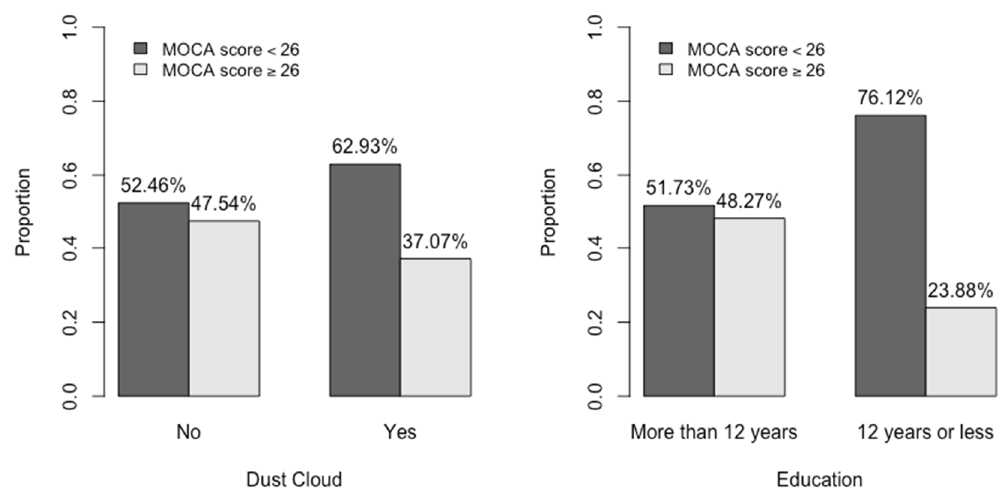
Figure 1. Dust cloud and education level in those with MoCA scores <26 and ≥26.